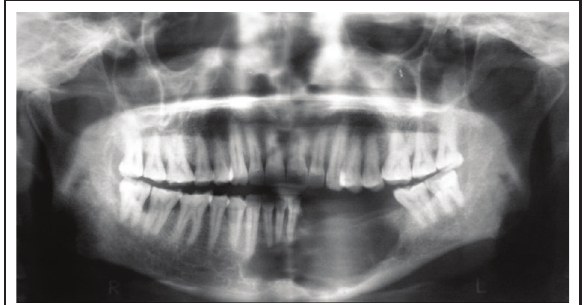
Figure 2. Odontogenic epithelial islands and cords in a dense fibrous connective tissue stroma with a stellate or an “animal-like” configuration. (Hematoxylin-eosin stain, 40x).